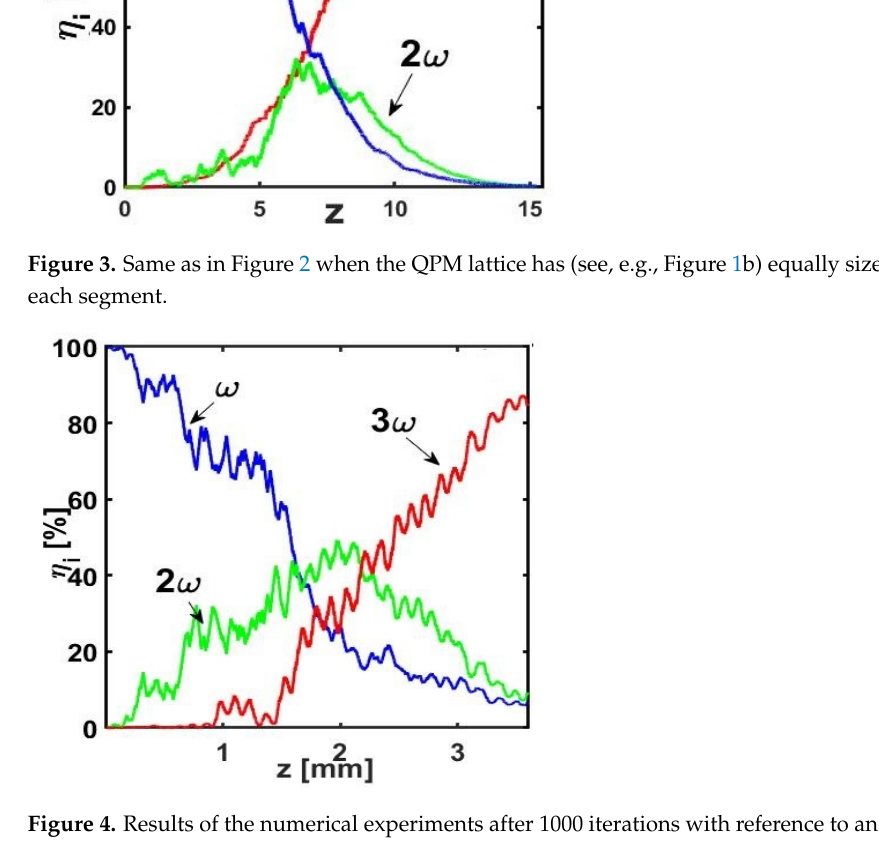
Figure 4. Results of the numerical experiments after 1000 iterations with reference to an aperiodi ‐ cally poled (z ‐ cut) Lithium Niobate crystal with a total length of 4 mm. Normalized intensities η i ( i = 1, 2, 3) at the three frequencies along the propagation distance z for different domain sizes in each segment.